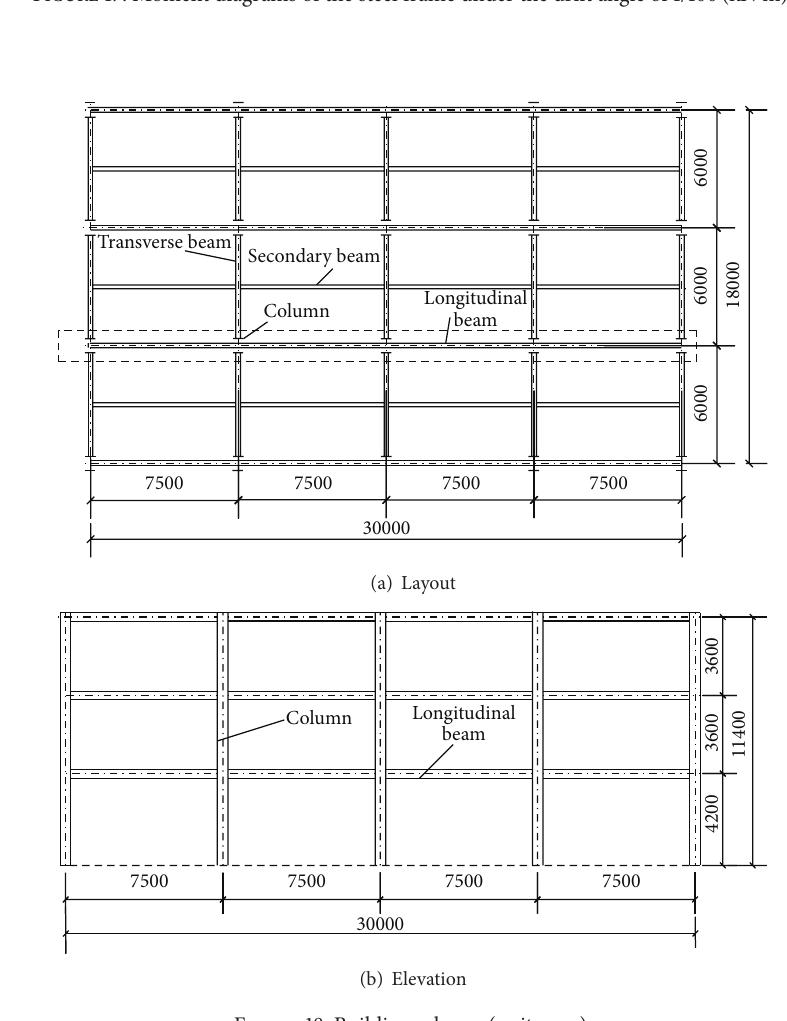
Figure 18: Building scheme (unit: mm).